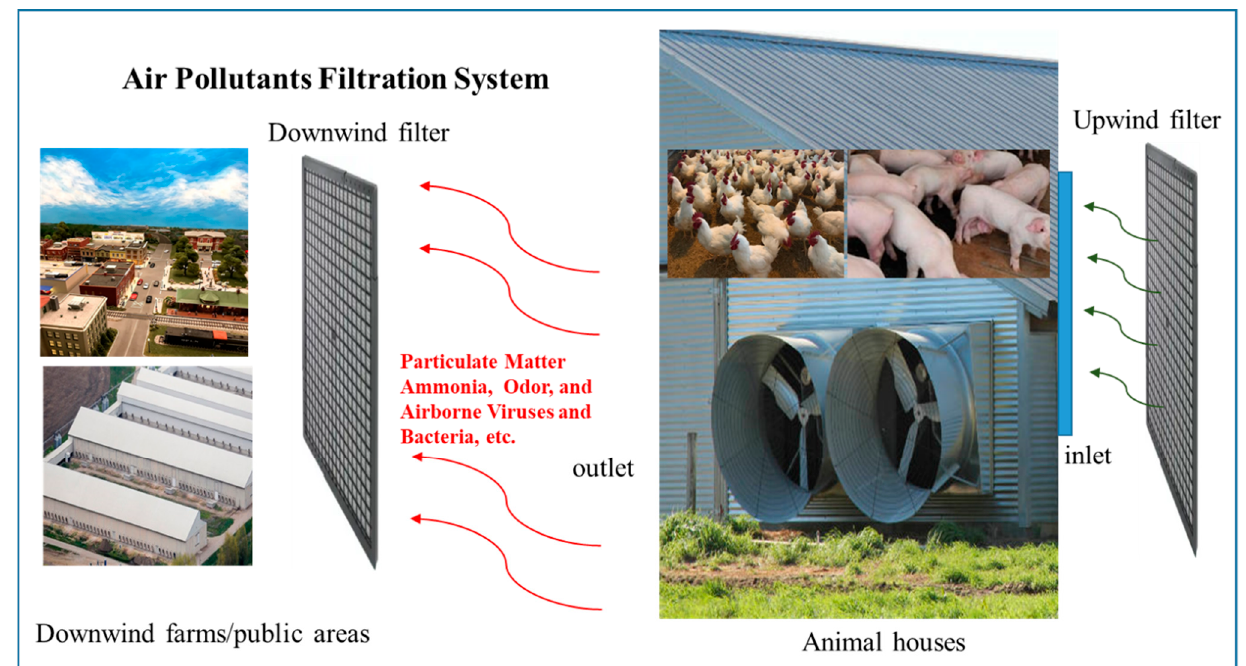
Figure 2. Diagram of air pollutants filtration system for animal houses.